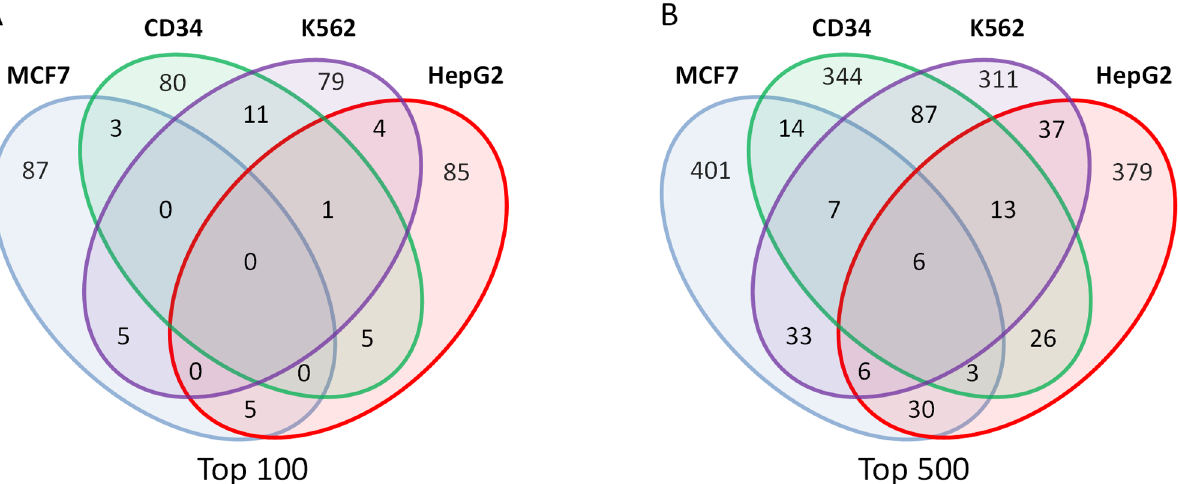
Fig 6. Gene comparison in multiple cell types. A: Venn diagram showing the level of overlap between the top 100 gene targets in each cell line tested. B: As (A) but considering overlap of the top 500 genes in each cell line.